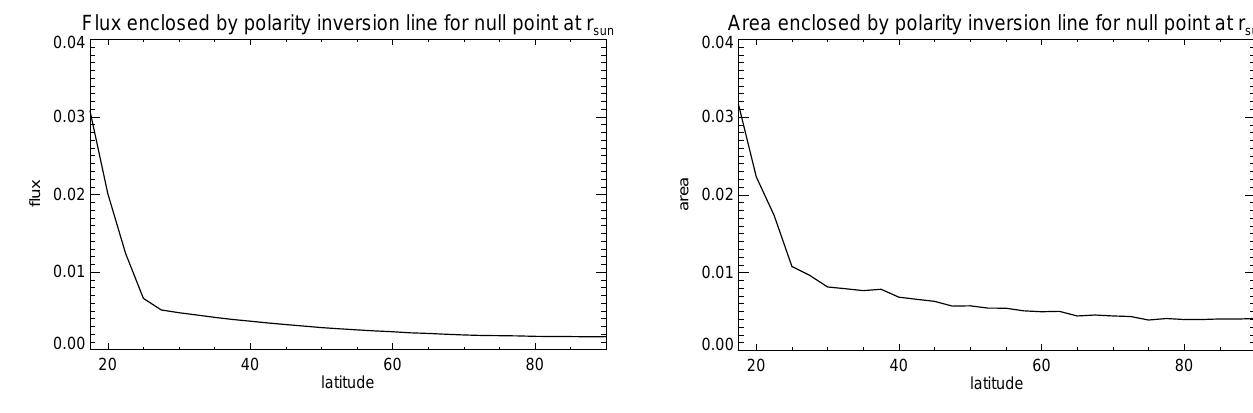
Fig. 5. Area enclosed by polarity inversion line as a function of solar latitude for a null point at r = r (cid:12) . This plot shows that large nested polarities only occur close to the